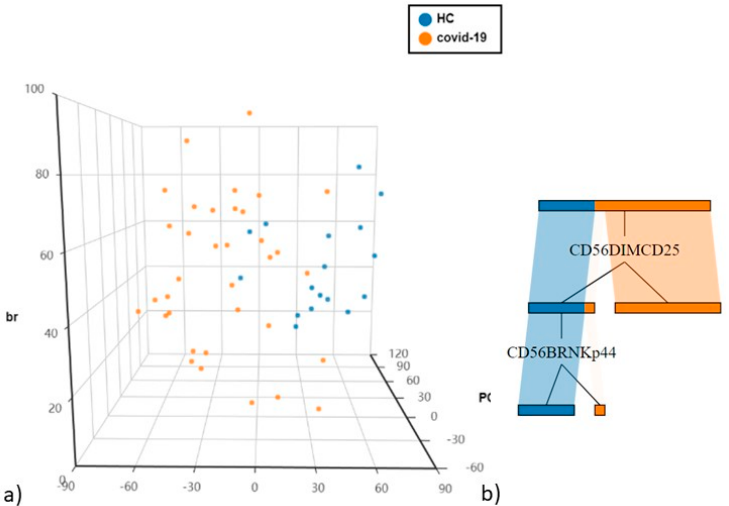
Figure 3. ( a ) Principal Component Analysis (PCA) of NK cells and T cell subsets ( b ) The cellular subsets of patients were employed to create a decision tree model for the detection of best clustering variables between the two groups.